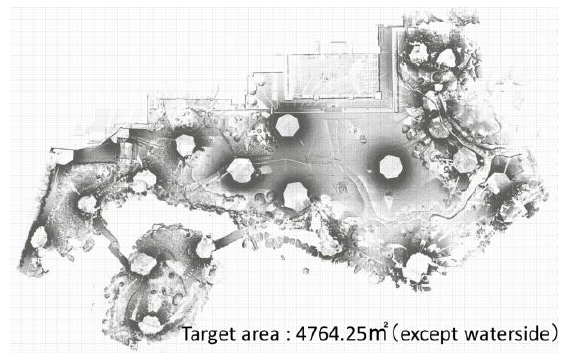
Figure 1. Target area for constructing 3D tree